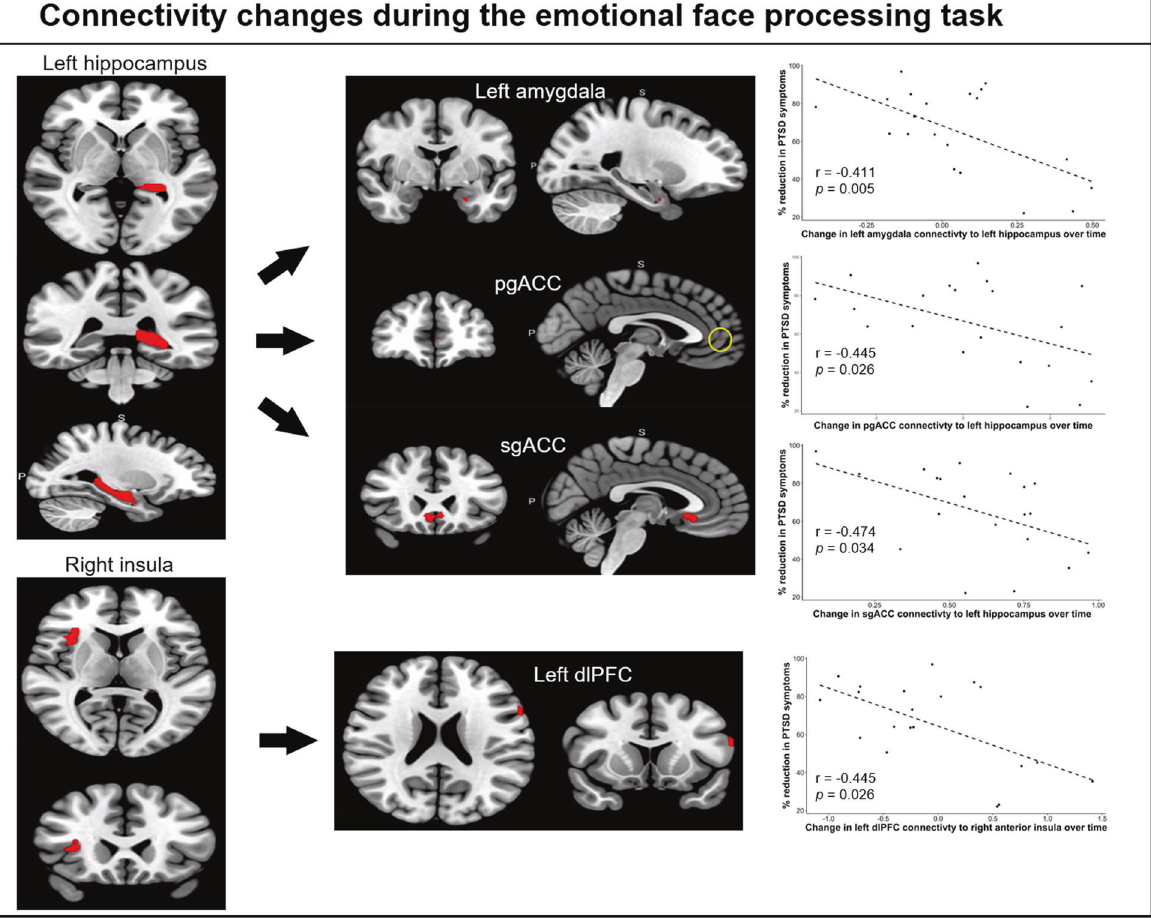
Fig. 3 fMRI connectivity changes during the emotional face processing task. Changes in connectivity of the left hippocampus to the left amygdala, pgACC and sgACC, and of the right insula to the left dlPFC, signi fi cantly correlated with changes in PTSD